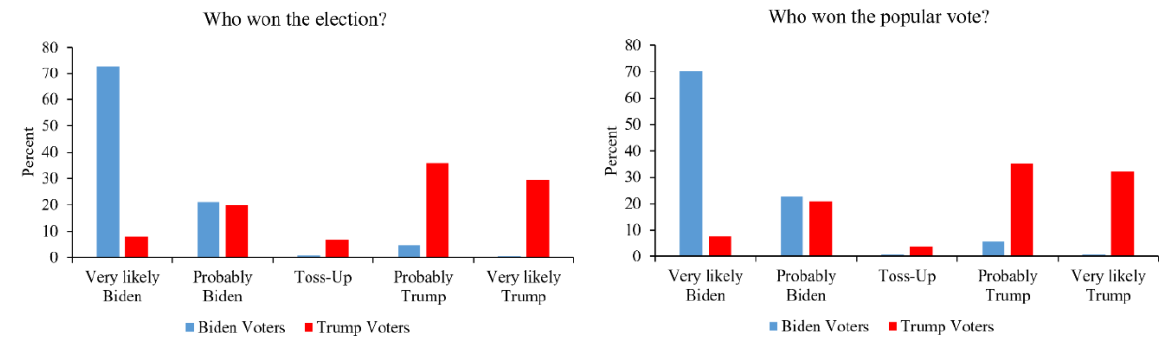
Figure 2. Belief in who won the election . Majorities of Trump voters believe him to have won the election, whereas Biden voters are confident that Biden won the election. Participants were asked “Who do you believe won the 2020 Presidential Election?” (left panel) and responded on a scale from 0 (Definitely Joe Biden) to 100 (Definitely Donald Trump), with 50 indicating “It’ s a toss- up”. This was counterbalanced across participants so that half o f the time 0 = Definitely Donald Trump (these were converted to be the opposite for ease of reporting). Participants were also asked (right panel) “Whether or not they win the electoral college (and therefore the election), who do you believe got the most total votes (i.e., won the popular vote) in the 2020 Presidential Election?” or “Whether or not they win the electoral college (and therefore the election), who do you belie ve got the most total legal votes (i.e. won the popular vote excluding any fraudule nt ballots) in the 2020 Presidential Election?” – including the word “legal” did not have an impact on the results among Trump voters, t(1020) = .837, p = .403, or Biden voter s, t(602) = 1.56, p = .119, and thus we collapsed across wordings in the figure. The order of the response scale was also counterbalanced across participants for the voting